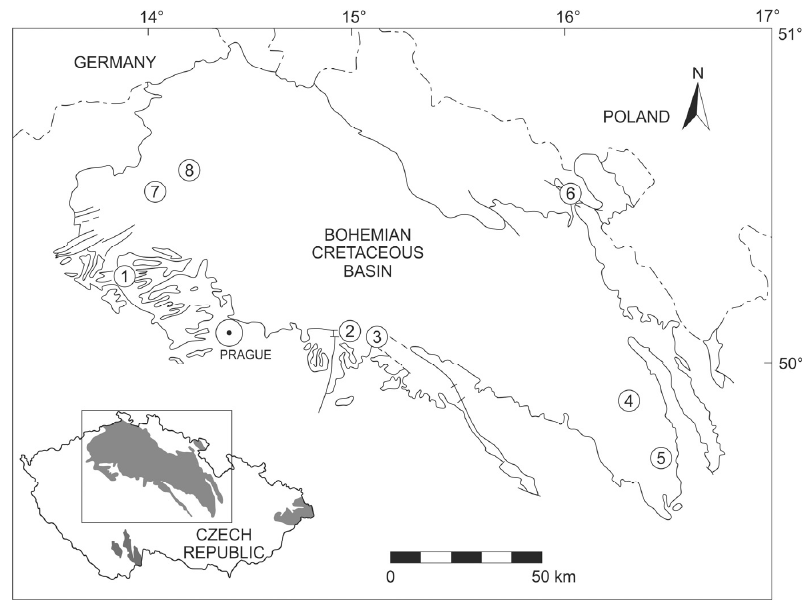
Figure 1. Map of the Bohemian Cretaceous Basin showing the location of the Cenomanian–Turonian phosphate-bearing sections: (1) Pecínov quarry, (2) Pla ň any quarry, (3) Nová Ves quarry, (4) Č eská T ř ebová “T ř ebovské st ě ny”, (5) B ř ezinka–Chvalka, (6) Rtyn ě v Podkrkonoší, (7) Úpohlavy quarry, and (8) Bý č kovice road-cut. Minerals 2021 , 11 , x FOR PEER REVIEW